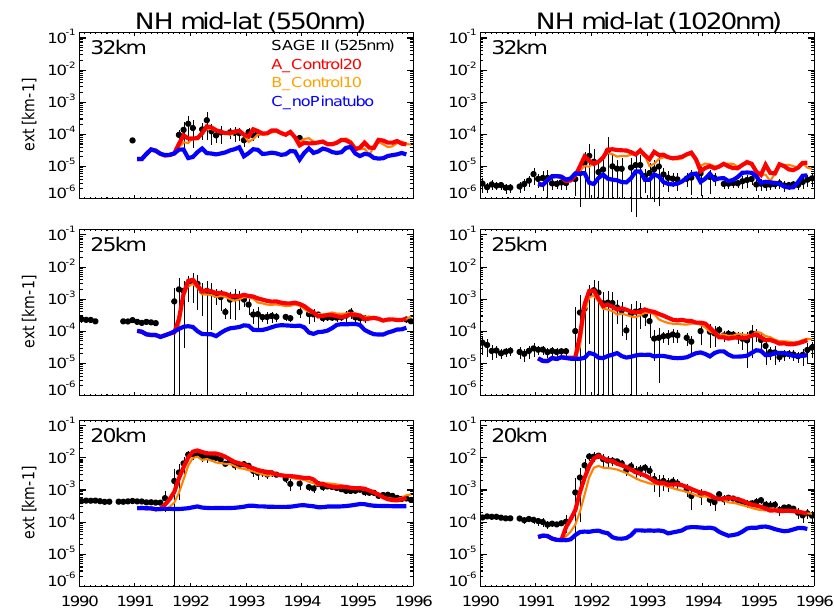
Figure 6. Same as Fig. 5 but for NH mid-latitudes (35–65 ◦